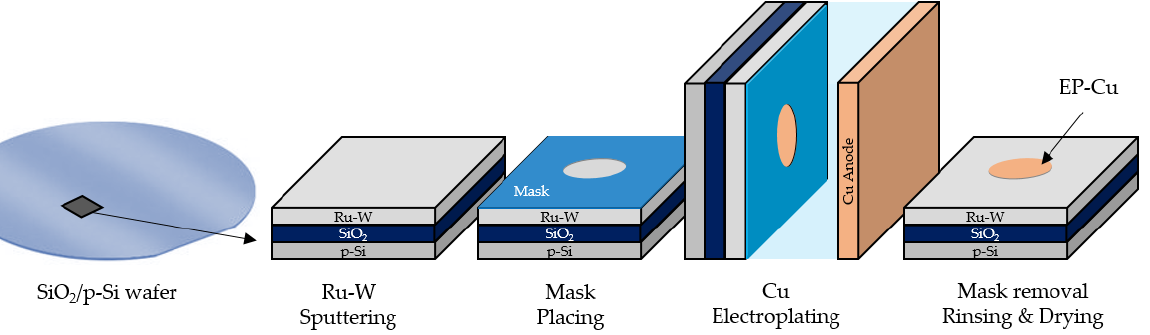
Figure 1. Schematic sequence of substrate preparation and Cu electroplating.